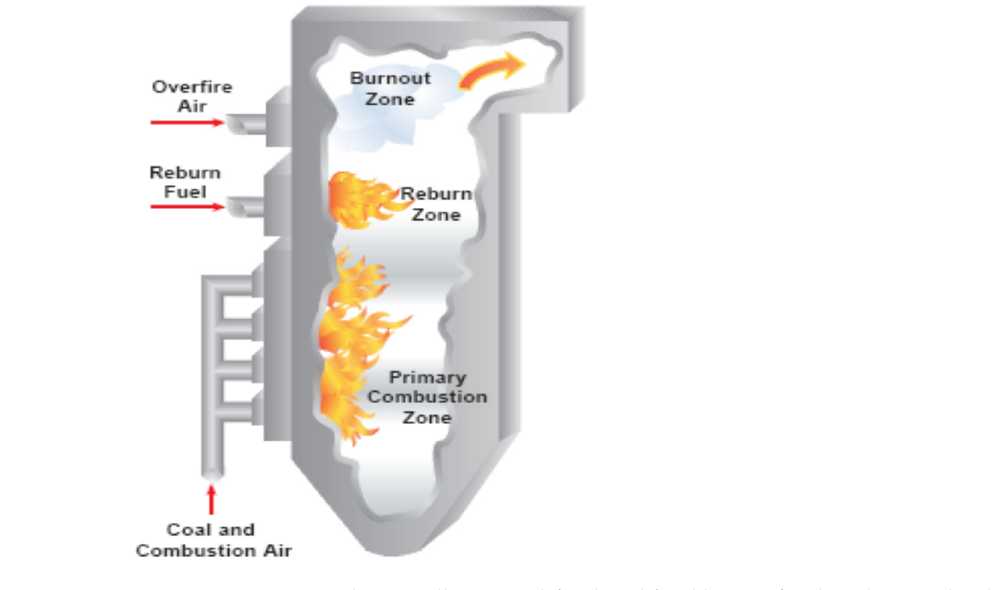
Figure 1. Conventional, vertically upward-fired coal fired burner for the reburn technology [2]. Table 1. Literature review on reburn studies.